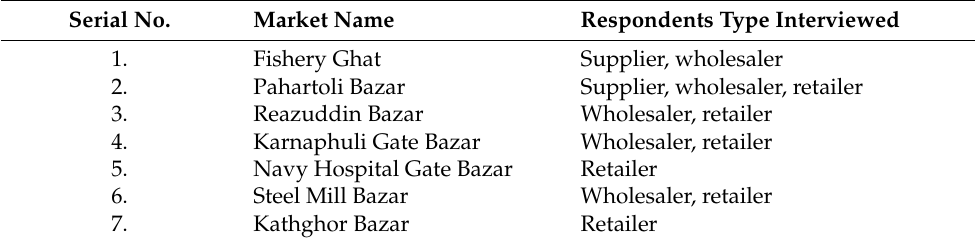
Table 2. Respondents’ characteristics across different market locations. Serial